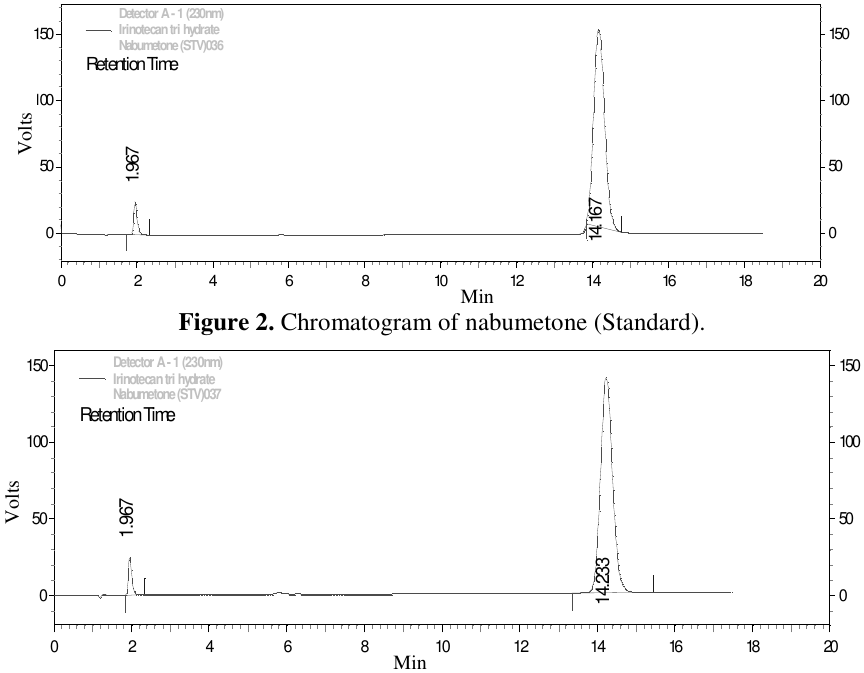
Figure 2. Chromatogram of nabumetone (Standard).